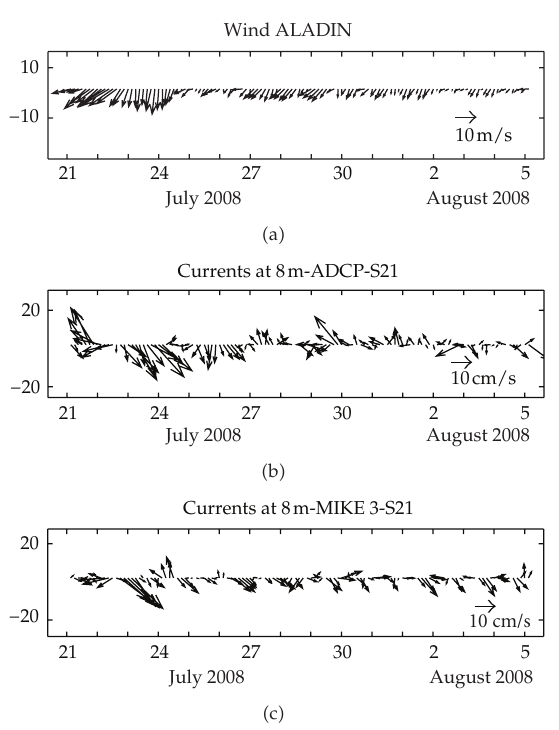
Figure 10: As in Figure 9 but for the ADCP station S21.